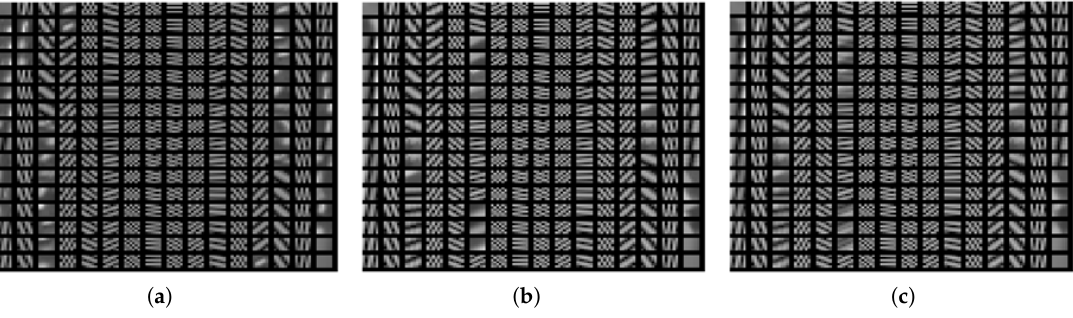
Figure 4. Learned dictionaries ( a ) dictionary from QuickBird Panchromatic images; ( b ) dictionary from band 1 of Multispectral Image; ( c ) The weighted dictionary ( α = 0.9, β = 0.3). Table 1. Quality measures and computing time for the Pavia dataset (256 × 256 × 93) (between brackets the applied images for the dictionary